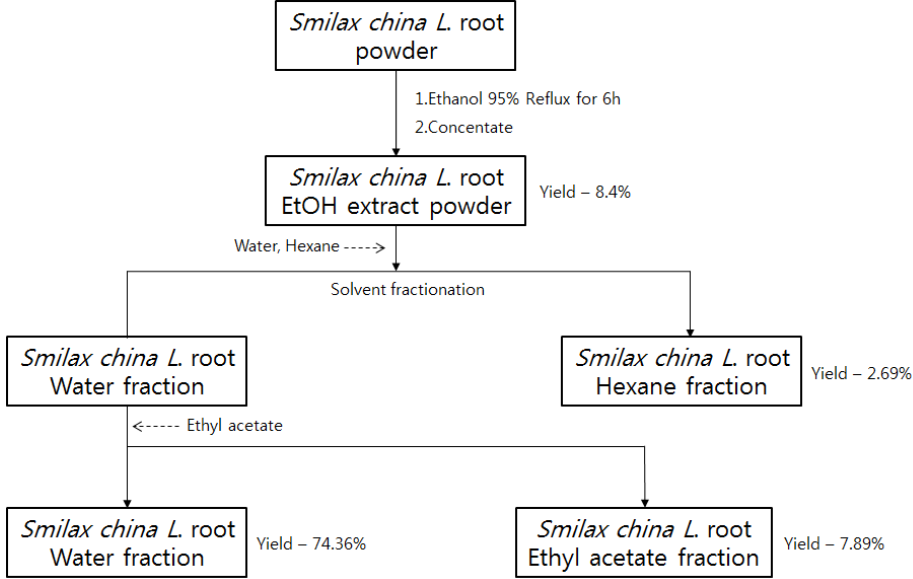
Figure 6. The flowchart of sample preparation.